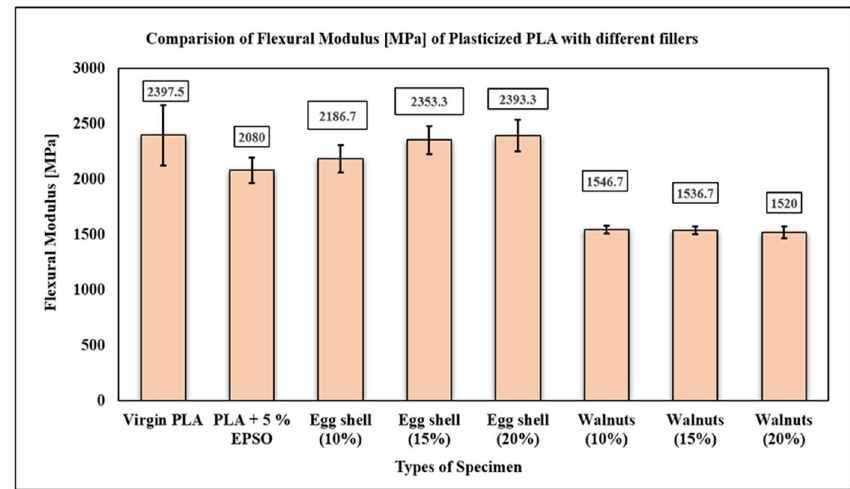
Figure 7. Flexural test result—Flexural modulus [MPa] comparison.